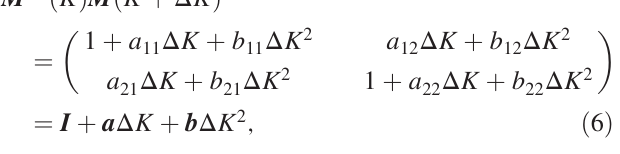
This equation can also be used also for a thick quadrupole by approximating β 0 ≈